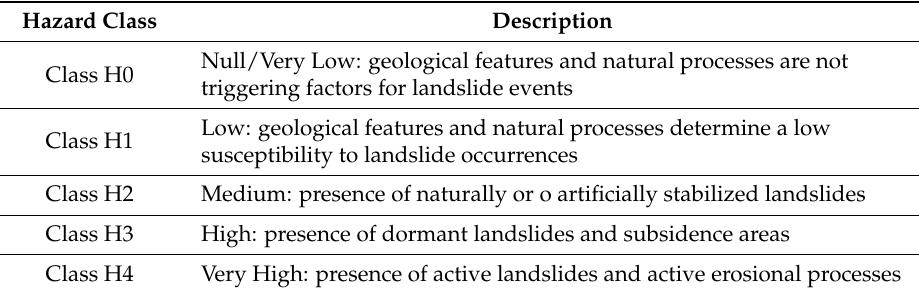
Table 2. Susceptibility (spatial hazard) classes according to the Italian Regional